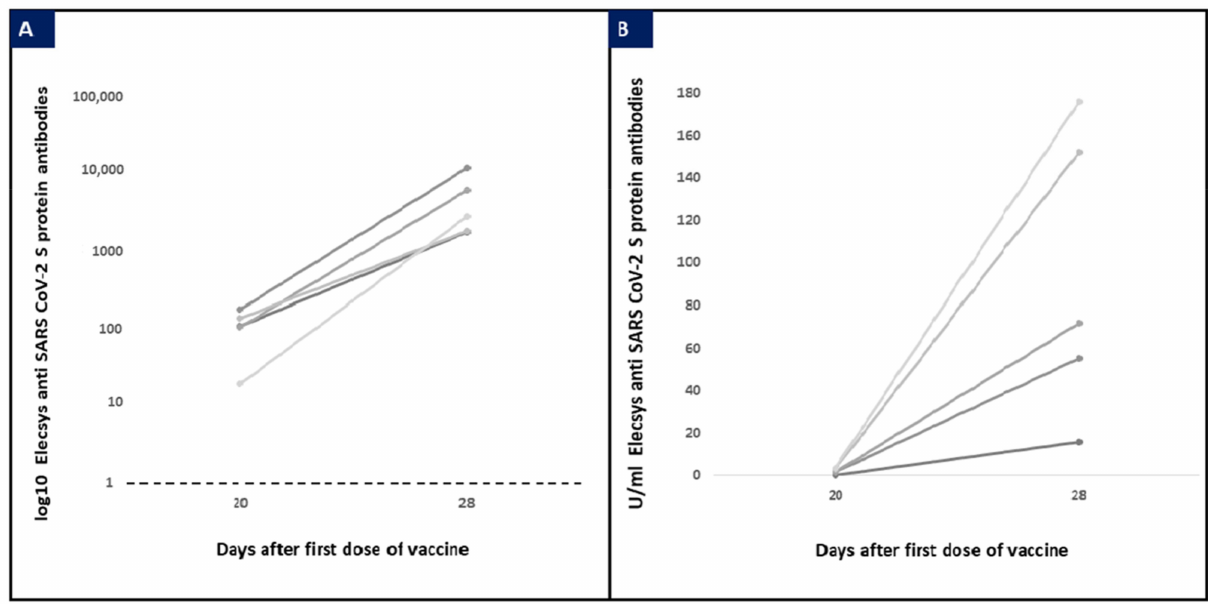
Figure 1. Log10 anti-SARS-CoV 2 S protein antibodies in maternal serum ( A ) and U/mL anti-SARS-CoV 2 S protein antibodies values in milk samples ( B ) in patients tested 20 and 28 days after the first dose ( n =